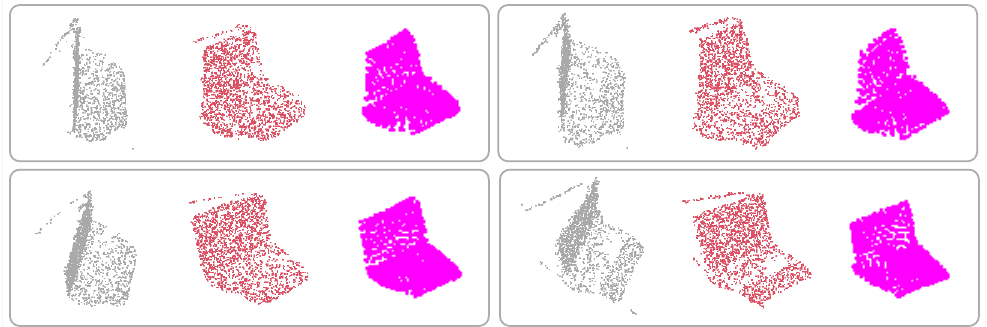
Figure 9. Sample results from experiments on real data. Our method can deal with clutter and missing pixels (points) challenges. In each triplet, left is the rotated input cloud, middle is the canonicalization, and the right-most is the denoised and the